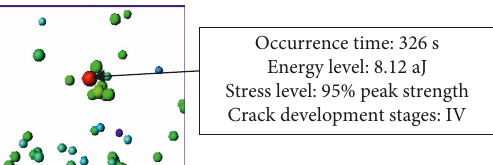
Figure 6: The spatial distribution of the AE events in the area outlined by the solid lines in Figure 5(b) at 323.7s.